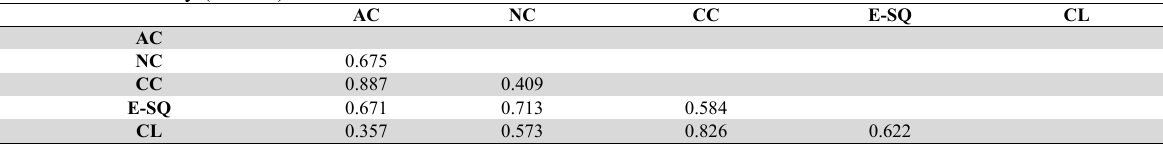
Discriminant validity